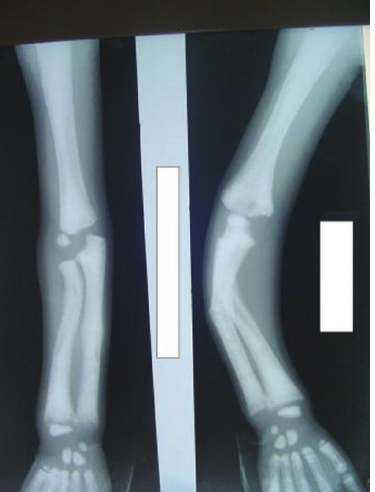
Figure 4: Radiograph of the upper limb showing bowing of the radius and